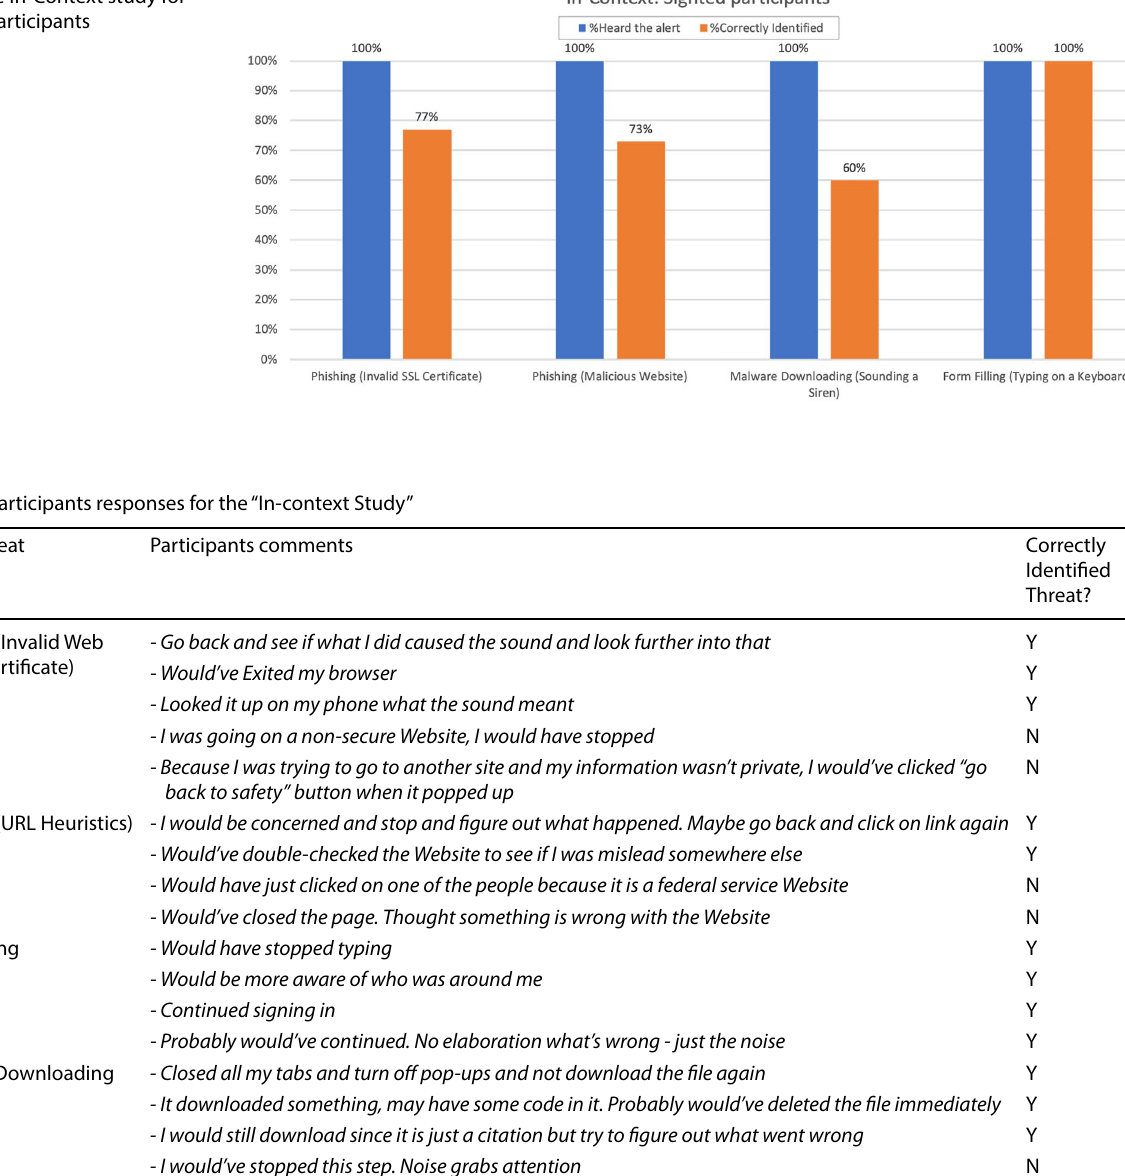
Fig. 7 The In-Context study for sighted participants